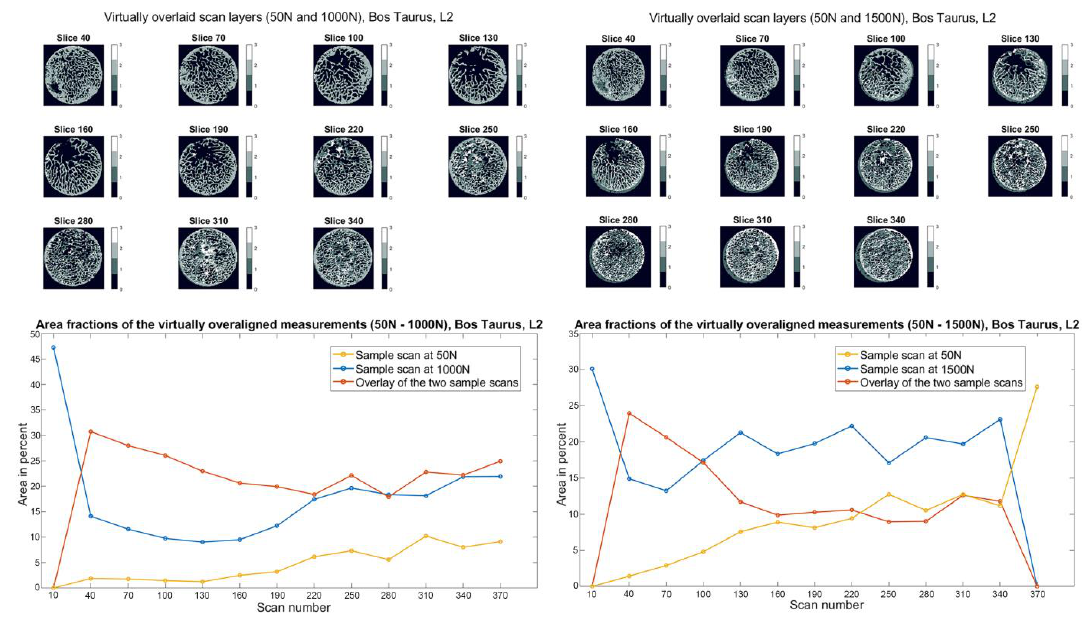
Figure 8. Slice view of the virtually superimposed 3D images (50 N and 1000 N, 50 N and 1500 N) from the Bos taurus L2 sample ( top ). The different components are declared in each layer with numbers from 0 – 3 and the corresponding color. 0 Background, 1 Sample image (1000 N/1500 N), 2 Superimposed area of the two 3D images, 3 Initial image (50 N). The course of the area fractions of the sample image (1000 N/1500 N), source image (50 N), and the superimposed area over the different layers are summarized in a diagram.